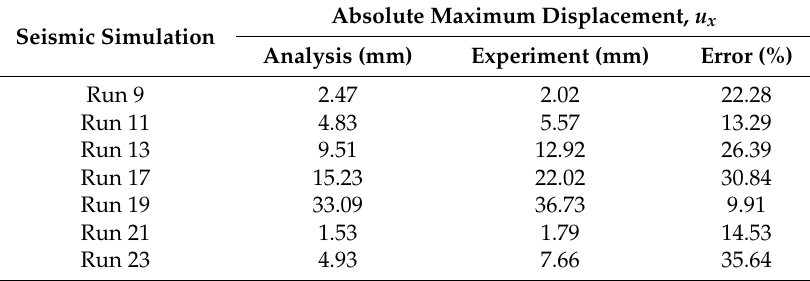
Table 10. Absolute maximum acceleration at point A on the third floor.